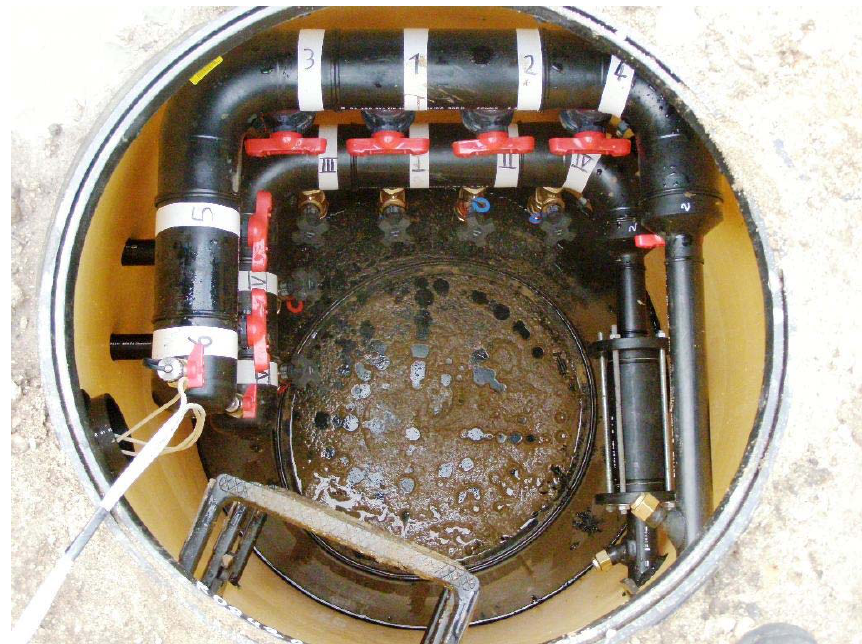
Figure 6. A snapshot of the measurements onsite. Two manifolds were installed, the lower one was for the fluid circulating to ground and the upper one was for the fluid circulating to the building. The marked 1, 2, 3, 4, 5 and 6 are for fluid circulate to the building; I, II, III, IV, V and VI are fluid circulate to the